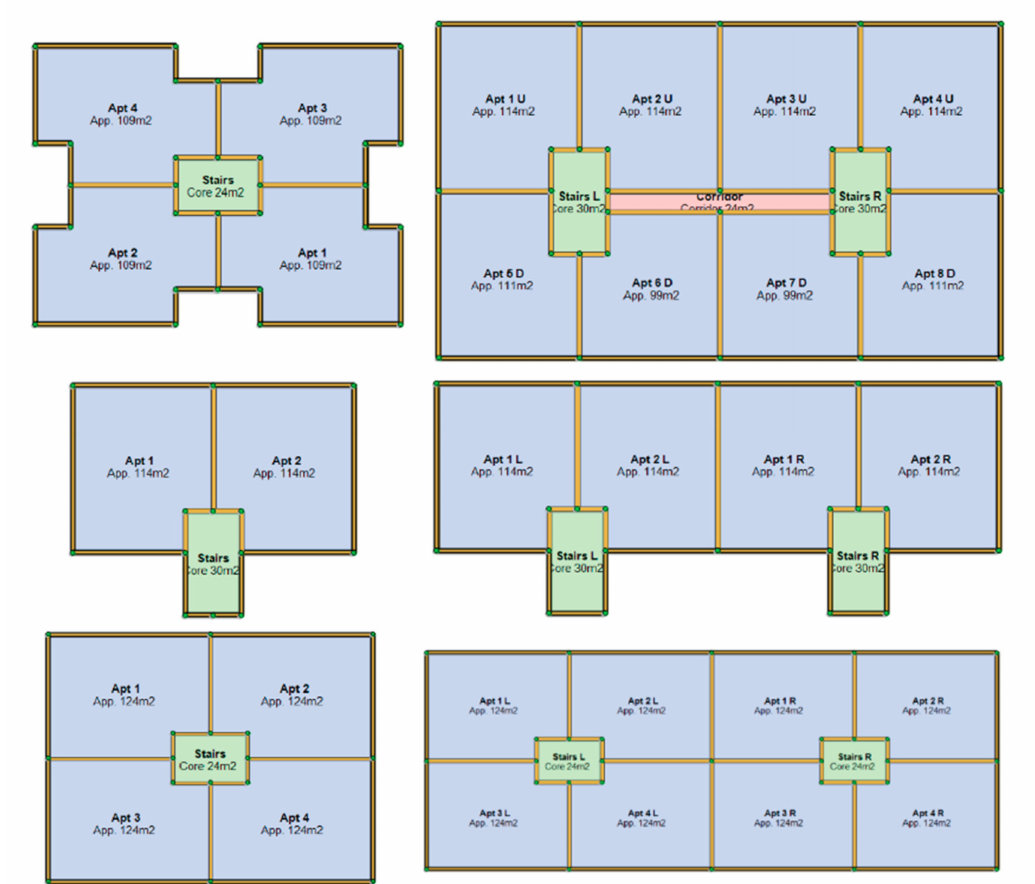
Figure 3. ENERGYui residential